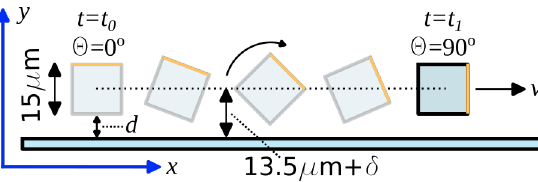
Figure 6. Crystal slice near the bottom of the